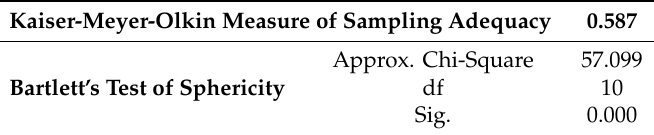
Table 4. KMO and Bartlett’s Test for factor analysis.